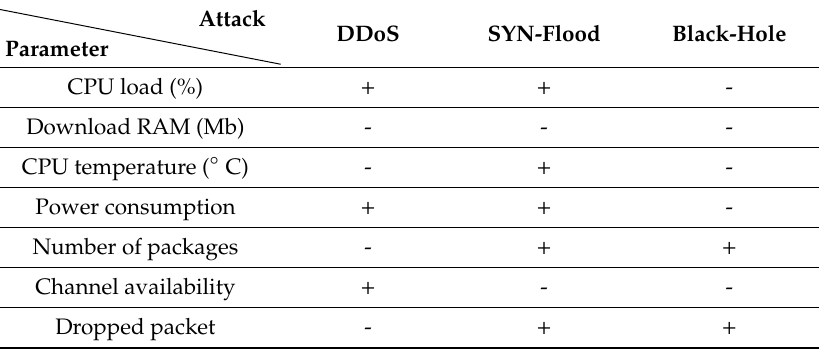
Table 3. The impact of attacks on the characteristics of the mobile device. DDoS—distributed denial of service; CPU—central processing unit; RAM—random-access memory. Attack DDoS SYN-Flood Black-Hole Parameter CPU load (%) + + - Download RAM (Mb)